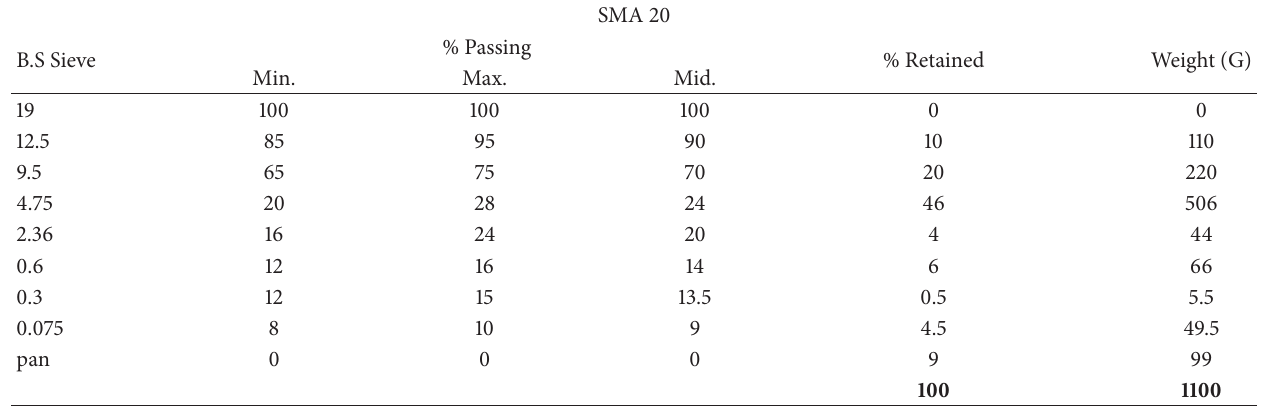
Table 2: SMA 20 aggregate